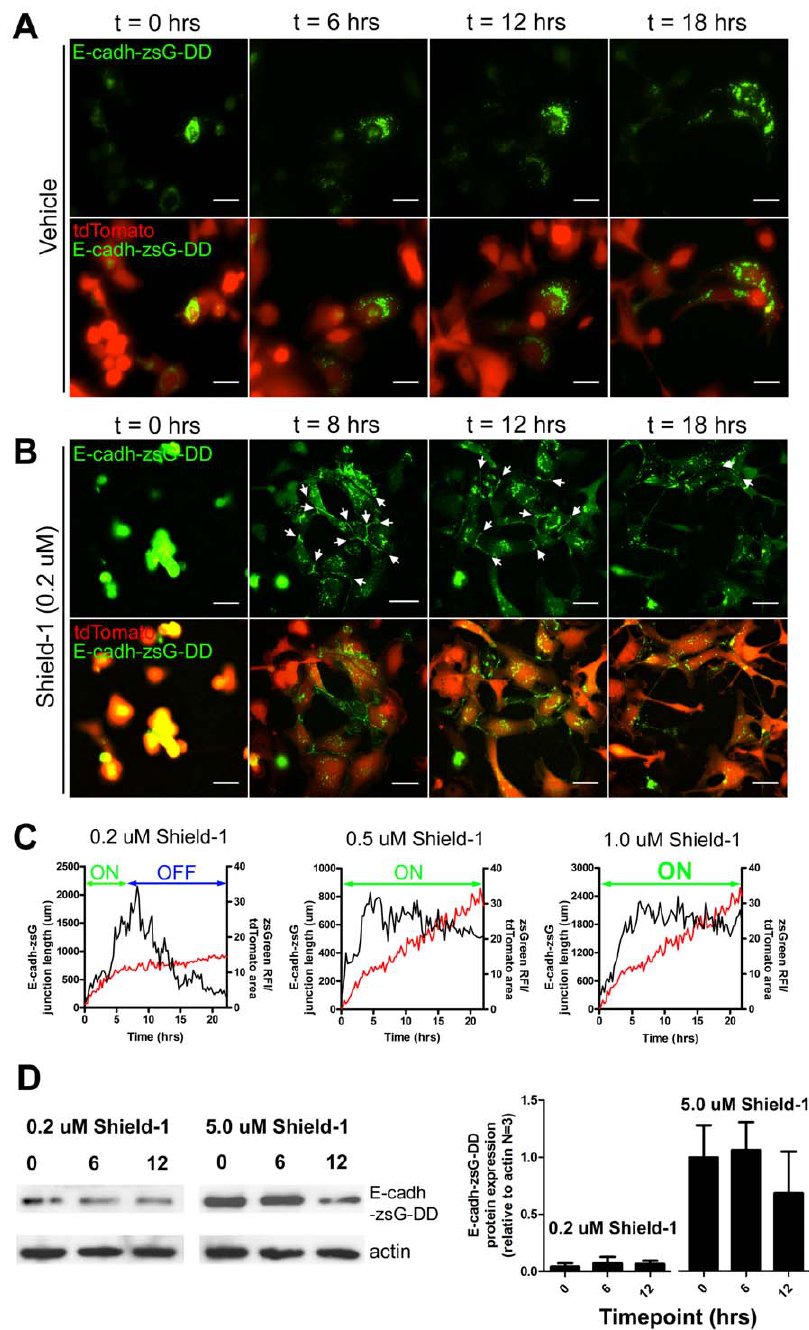
Figure 5. Time-lapse imaging of E-cadherin induction and kinetics of cell-cell junction formation invitro . Fluorescence in vitro time- lapse imaging of 231LN cells containing inducible E-cadherin treated with vehicle (A) or 0.2 m M Shield-1 which will produce an induction and depletion effect over 24 hours (B). Data Scale bar is 25 m m. C) Measure of ‘‘actively engaged" E-cadherin in 231LN cells in the presence of varying levels of Shield-1 (0.2, 0.5, and 1.0 m M Shield-1), expressed as the cumulative length of all zsG-positive adherens junctions over time ( m m/hrs) in representative time-lapse experiments. The black kinetic represents the total cumulative length of E-cadherin-based junctions within a field of view at that timepoint while the red kinetic represents the accumulation of zsGreen-DD exposed to similar Shield-1 treatment. The ‘‘induction’’ and ‘‘depletion’’ phases of chemical induction are annotated in each graph. D) Conditioned media collected from cells expressing pzsGreen-DD which were treated with 0.2 m M Shield for 0, 6 and 12 hours were used to induce E-cadherin-zsGreen-DD expression in 231LN cells expressing E-cad-zsG-DD. There is induction with the 0 and 6 hours conditioned media, but minimal effect with the 12 hour conditioned media. Conversely, conditioned media from cells treated with 5.0 m M Shield-1 induced E-cadherin-zsG-DD expression regardless of the time of conditioned media collection. Graph (Figure 5D, right) represents data from three independent western immunoblot experiments.